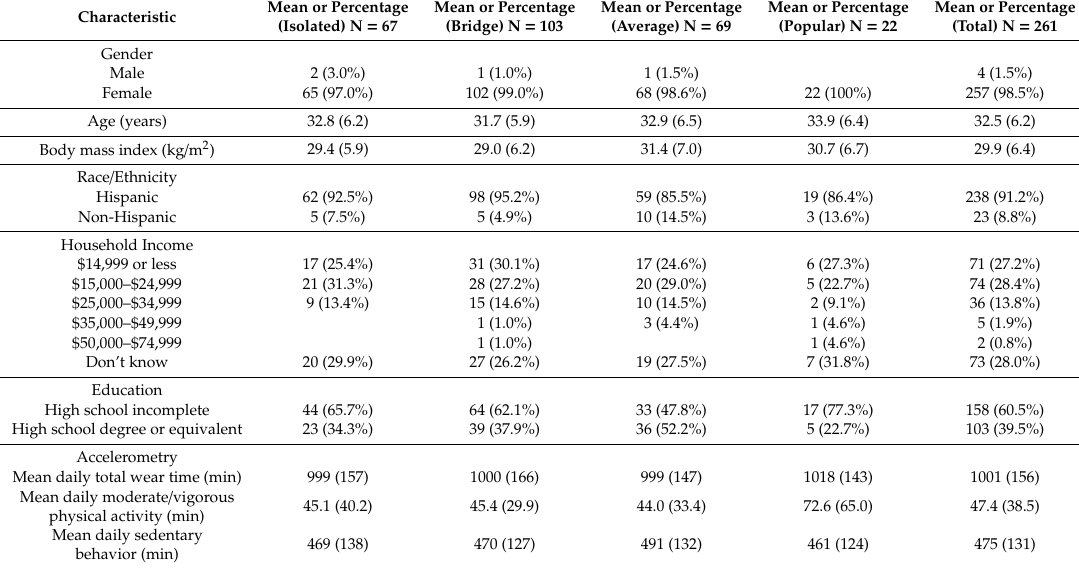
Table 2. Characteristics of network